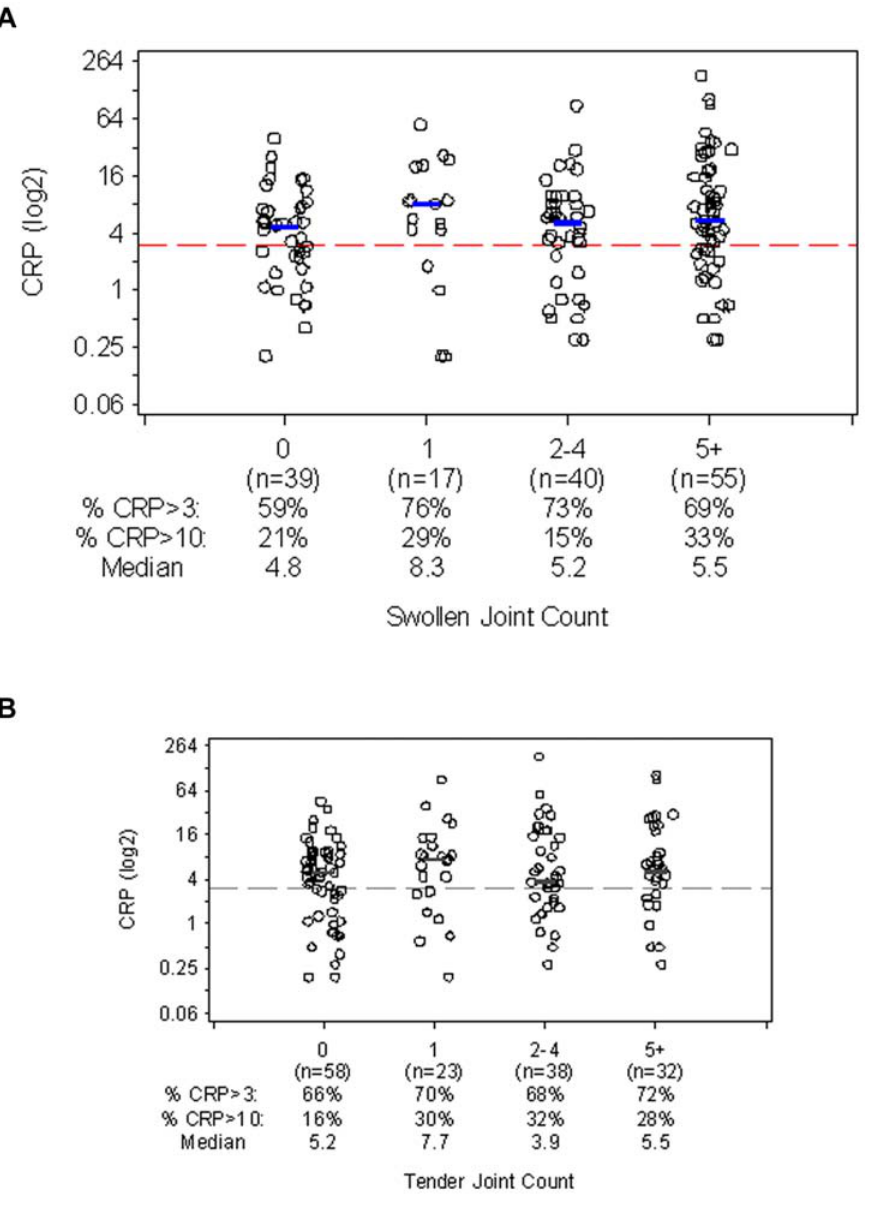
Figure 2. CRP Levels by (a) Swollen and (b) Tender Joint Count Category. CRP (log2) values are shown within each swollen joint count category. CRP levels and joint counts were determined at the same clinic visit. Blue lines denote location of the median. The dotted reference line is at CRP=3 mg/L.